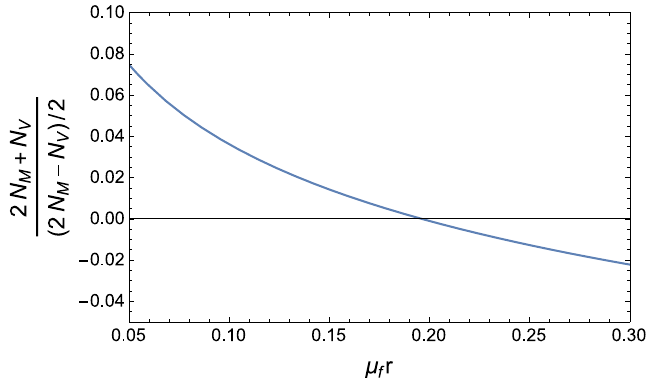
Figure 3 . Renormalon cancellation as a function of (cid:22) f in the logarithm.